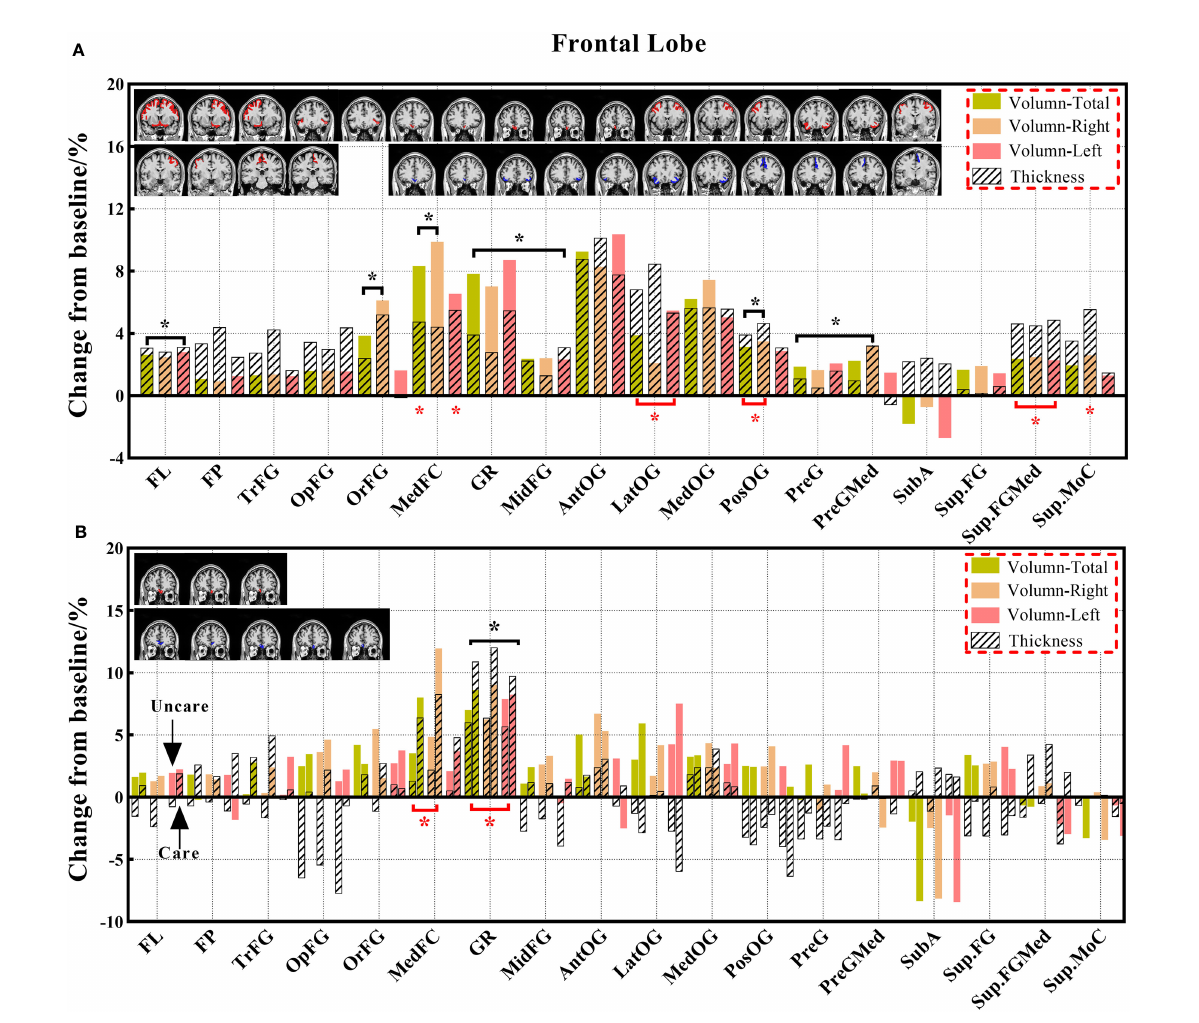
FIGURE 3 The changes in brain volume and cortical thickness from baseline in the frontal lobe. (A) represents the results of 14 subjects and (B) shows the results of the three groups. Solid and shaded histograms represent volume and cortical thickness, respectively. The coronal with red is the signi fi cant difference subregion for volume, and the blue for thickness. Green, orange, and pink on behalf of total, right and left. Black* and red* indicate a statistically signi fi cant difference (P<0.05) in volume and cortical thickness, respectively (The labels appearing in this fi gure and their interpretation are the same as those in the Figures 4 –